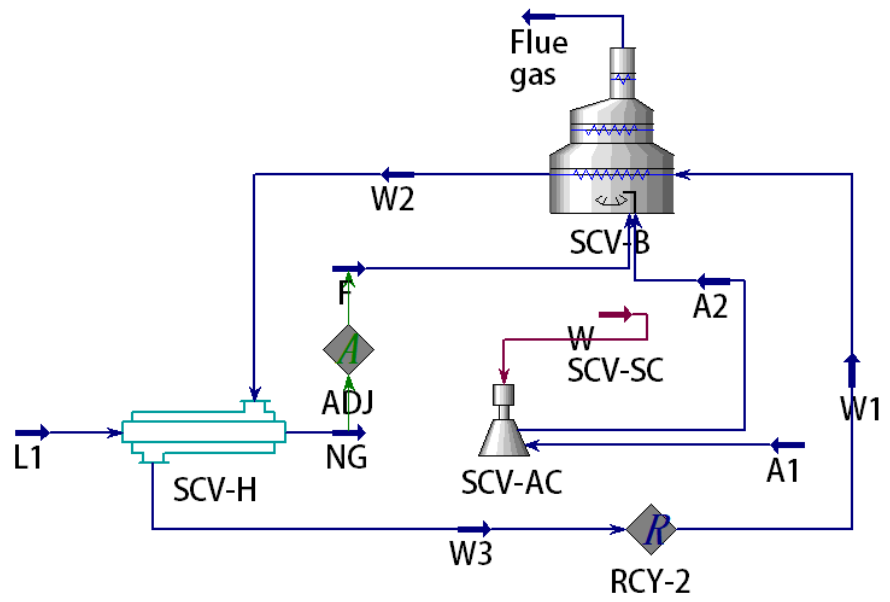
Figure 2. System B: HYSYS simulation model of conventional LNG regasification.